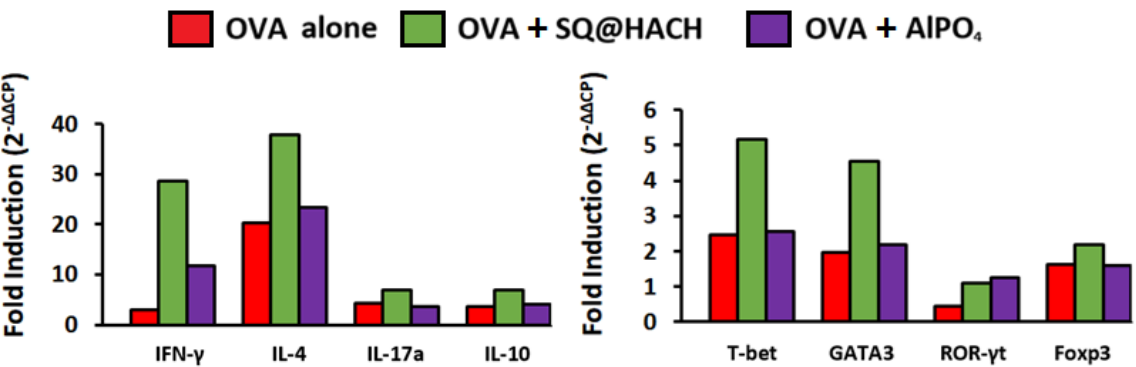
Figure 6. T cell-related mRNA quantification. Pooled splenocytes from immunized mice were obtained at day 14 after vaccination and re-stimulated with or without ovalbumin for 24 h. The quantification of T cell-related mRNA expression by RT-PCR for IFN- γ , IL-4, IL-17a, IL-10, T-bet, GATA3, ROR- γ t, and Foxp3. The fold induction is the ratio of the expression values with ovalbumin to those without ovalbumin. Results are expressed as the geometric mean of the housekeeping gene beta-actin which was used as an internal control to normalize the variability in expression levels.